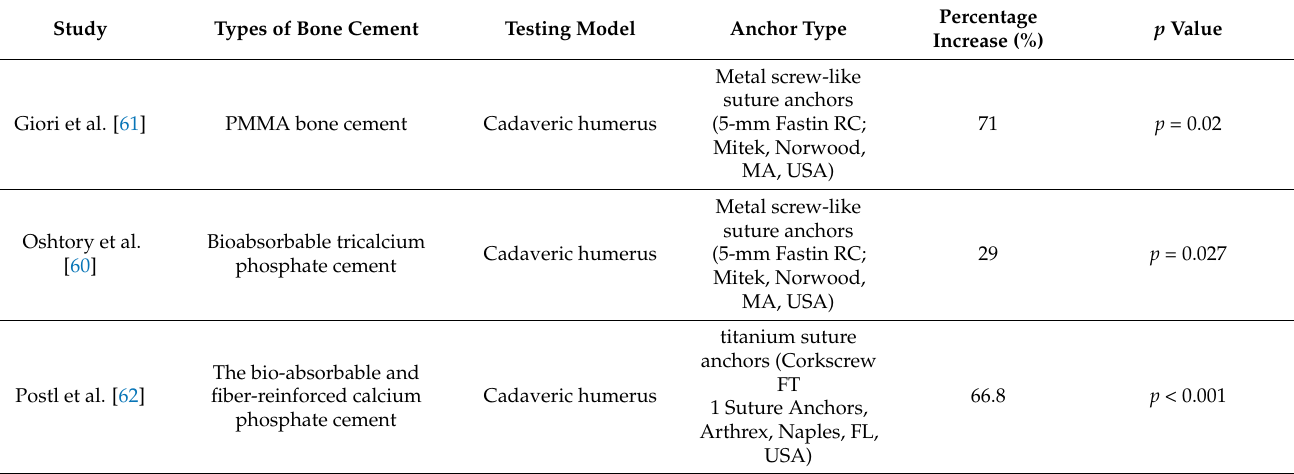
Table 1. Pullout strength increment for augmentation with different types of bone